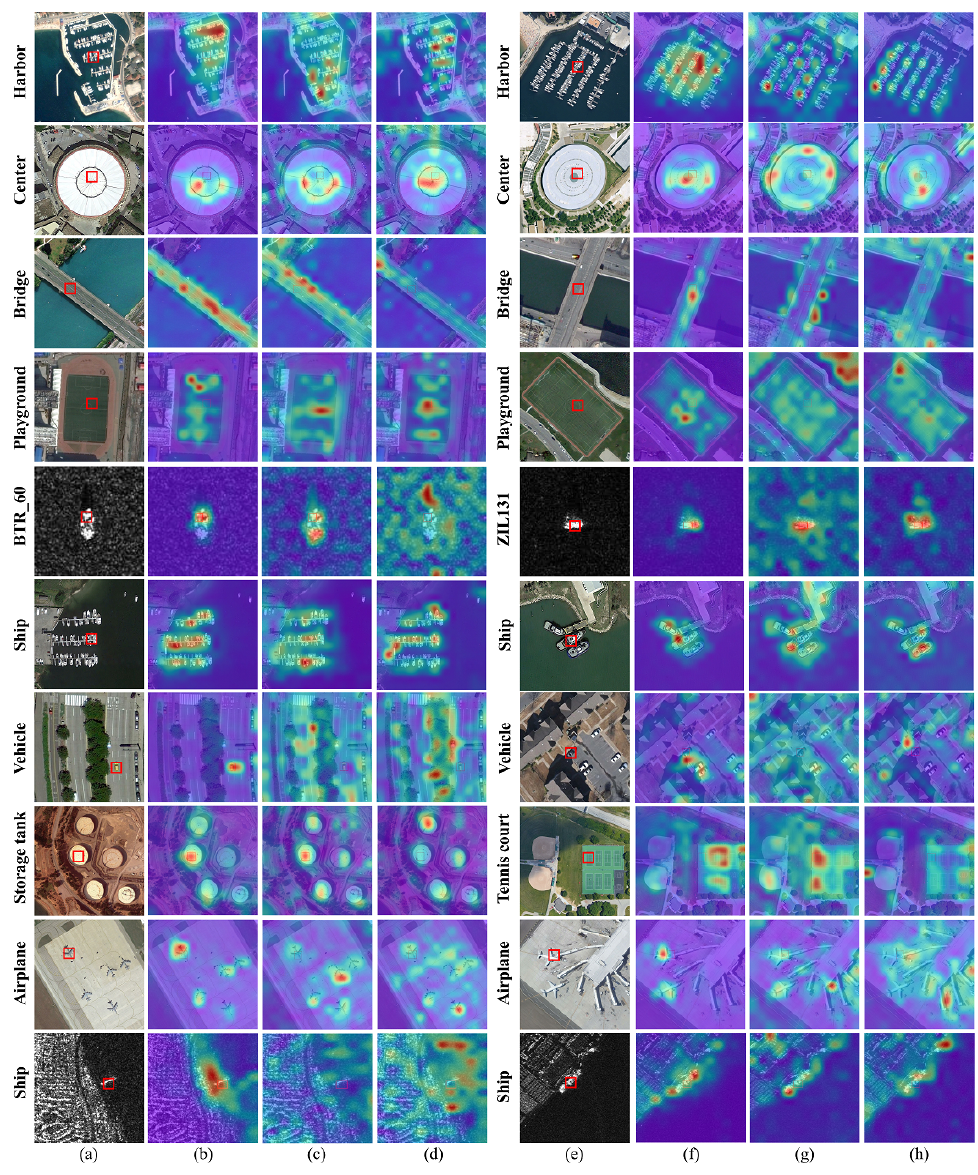
Figure 6. The comparison of self-attention maps. ( a , e ) columns represent original images which are from optical and SAR images; ( b , f ) columns are score maps produced by our proposed CSPT; ( c , g ) columns are score maps produced by self-supervised pre-training on M-AID [30] and then fine-tuning; ( d , h ) columns denote score maps produced by self-supervised pre-training on IN1K [18] and then